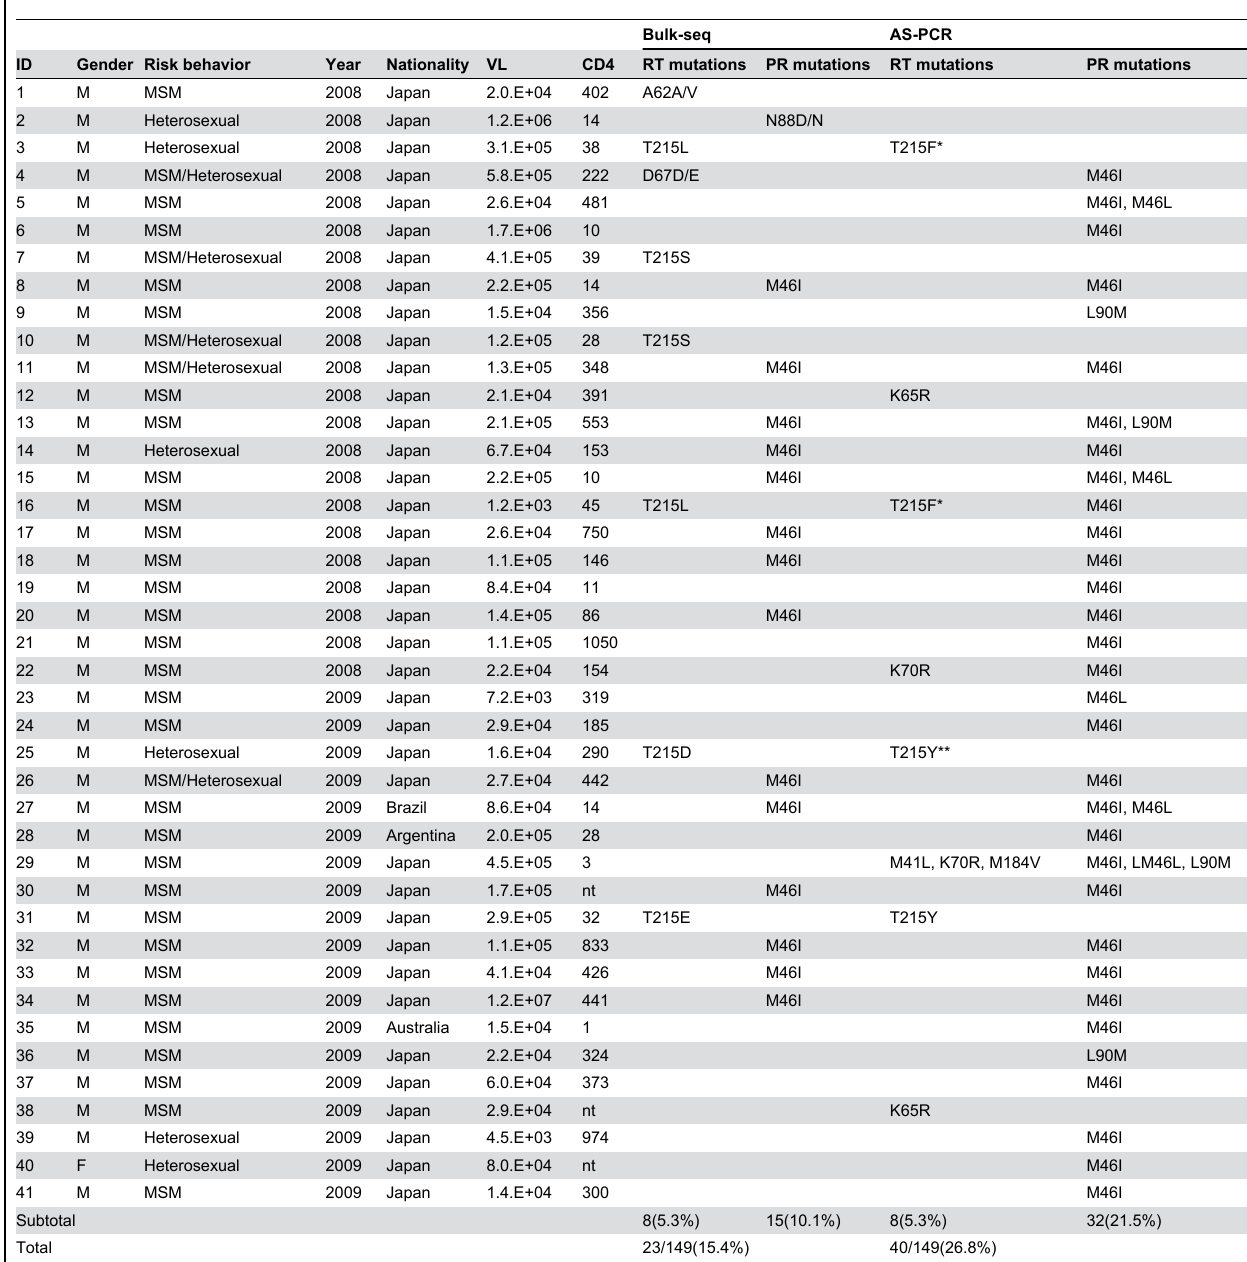
Table 2. Characteristics of HIV/AIDS patients with drug resistance